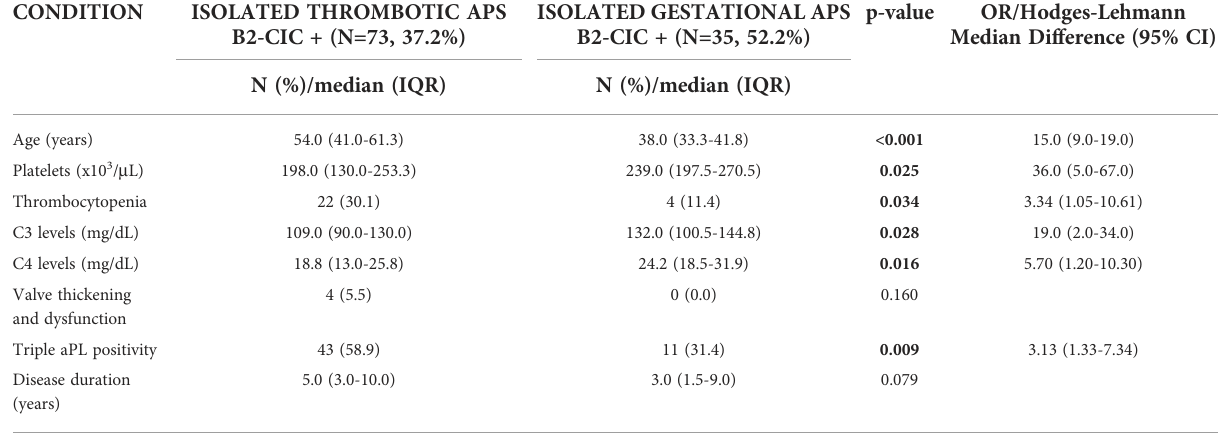
Table 4 Comparison of clinical and laboratory characteristics previously identi fi ed with a p-value <0.050 between B2-CIC-positive patients with isolated thrombotic APS and B2-CIC-positive patients with isolated gestational morbidity.